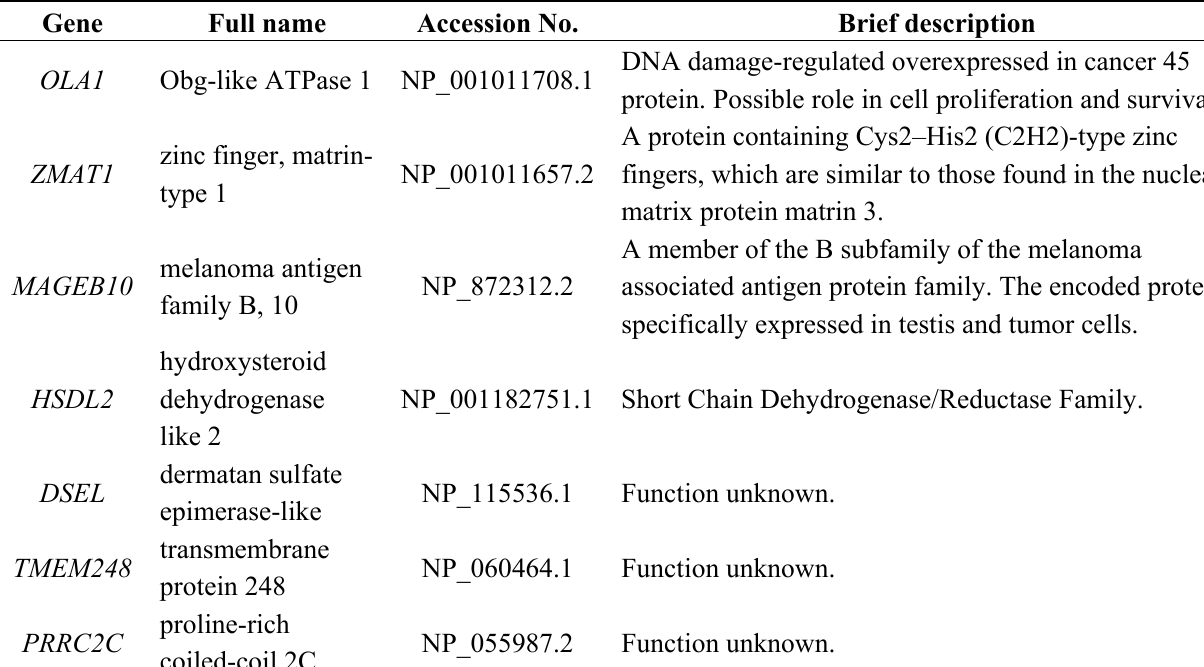
Table 6. Unclassified (7